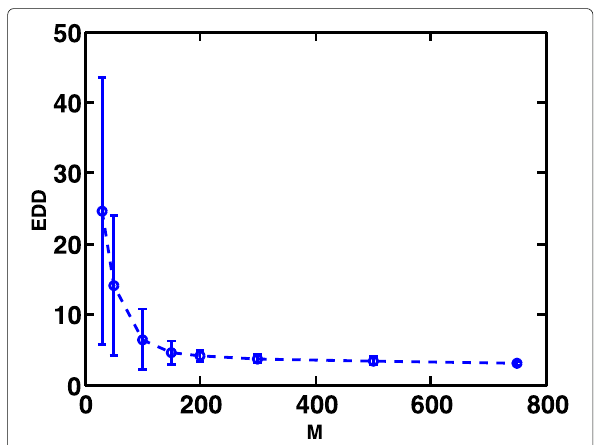
Fig. 11 Solar flare detection: EDD versus various M when A is an M -by- N Gaussian random matrix. The error bars are obtained from 10 4 repetitions with runs with different Gaussian random matrix A